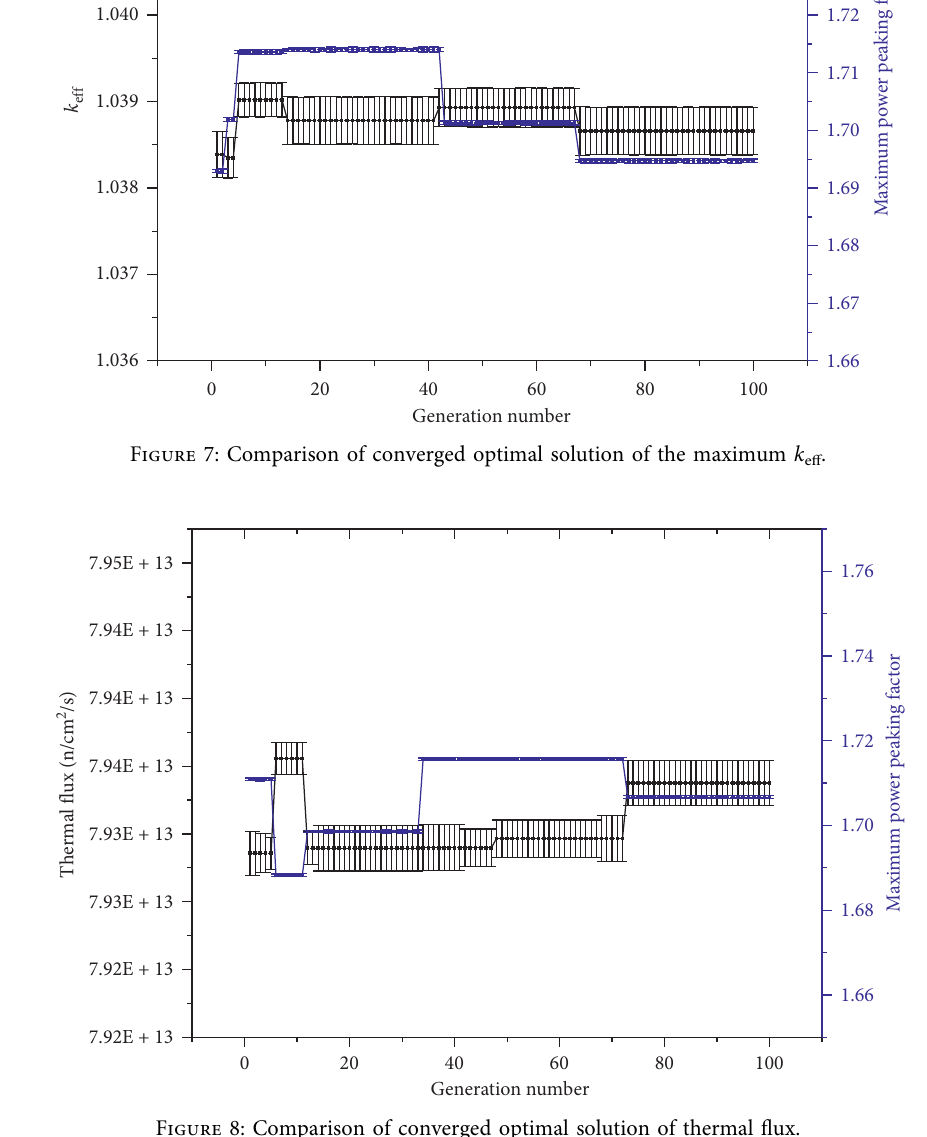
Figure 8: Comparison of converged optimal solution of thermal